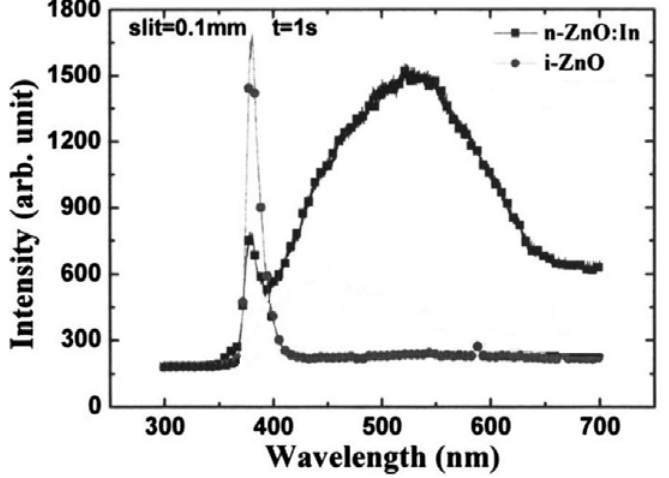
Figure 6. Room temperature PL spectra of the i -ZnO and n -ZnO:In films, excited at 325 nm. Reprinted from Ref. [39] with